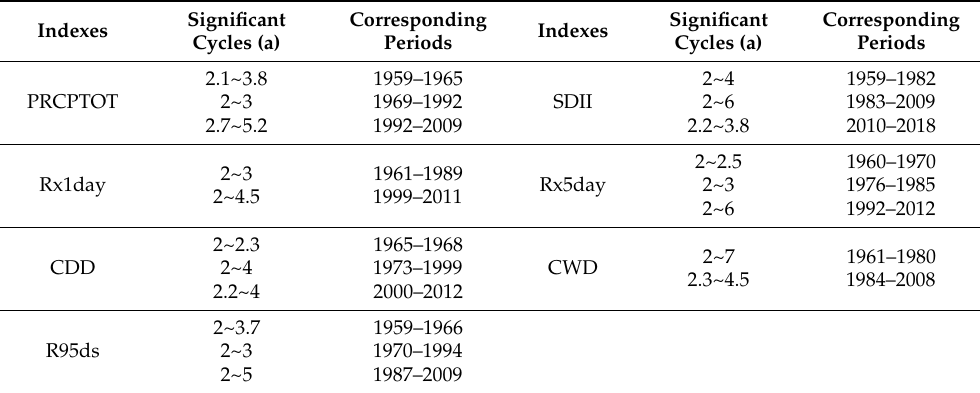
Table 4. Significant oscillation cycles and corresponding periods of continuous wavelet transforms of precipitation indexes in Beijiang River Basin.